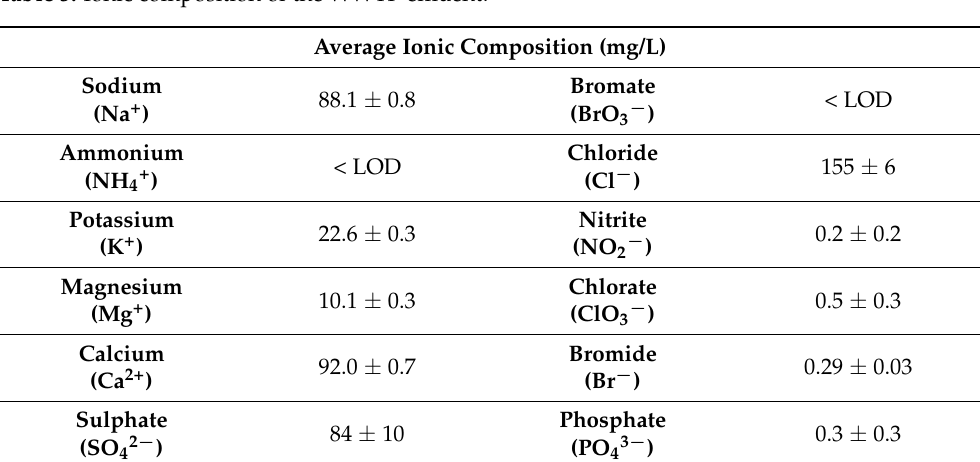
Table 3. Ionic composition of the WWTP